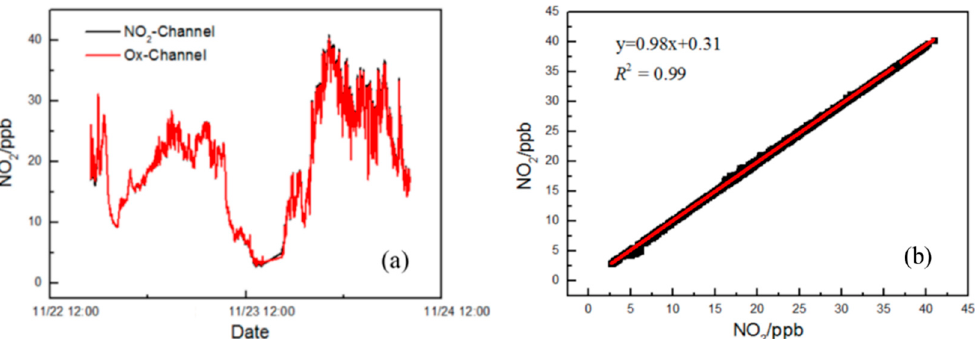
Figure 5. ( a ) Time series of ambient atmospheric NO 2 concentration sampled using the CRDS instrument in two channels. The time resolution is 1 s. ( b ) Correlation plot between the data from the two channels.